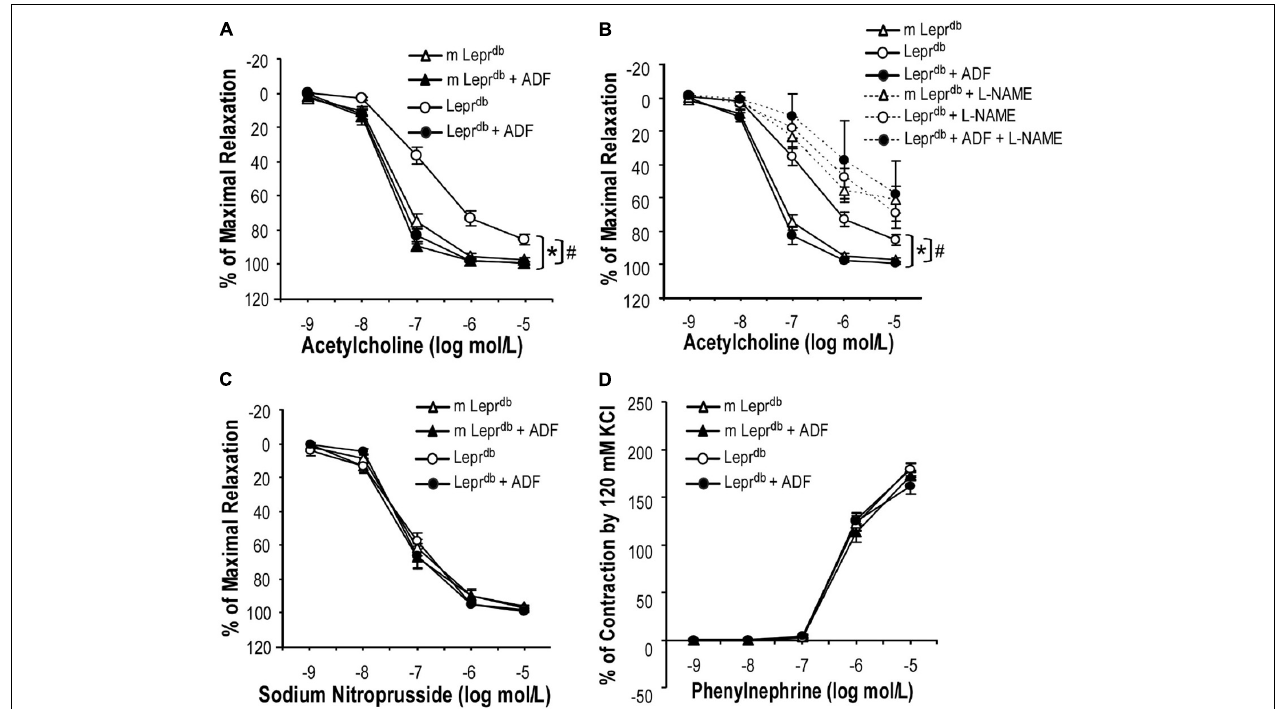
FIGURE 2 | ADF improved endothelium-dependent vasorelaxation without affecting endothelium-independent vasorelaxation or phenylephrine-induced vasoconstriction of small mesenteric arteries (SMA) in type 2 diabetic mice. (A) Acetylcholine (ACh)-induced endothelium-dependent vasorelaxation of SMA was impaired in Lepr db mice. Twelve weeks of ADF in Lepr db ( Lepr db + ADF) restored endothelium-dependent vasorelaxation back to the level of m Lepr db control mice. (B) Incubation with the nitric oxide synthase inhibitor (L-NAME) largely attenuated ADF-induced improvement of endothelial function in diabetic mice. (C) Sodium Nitroprusside (SNP)-induced endothelium-independent vasorelaxation of SMA was comparable among groups. (D) Phenylephrine (PE)-induced vasoconstriction of SMA was comparable among groups. Data represent mean ± SEM. n = 5 mice per group with 1–2 rings per mouse. * P < 0.05 vs. m Lepr db control mice, # p < 0.05 vs. Lepr db diabetic